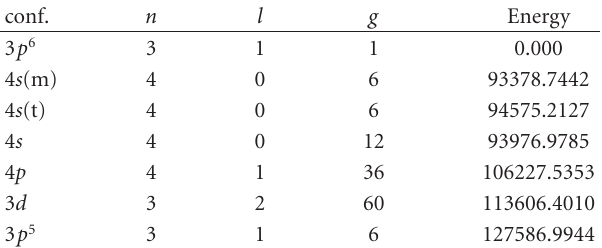
Table 2: Averaged energy levels of Ar I, II and their statistical